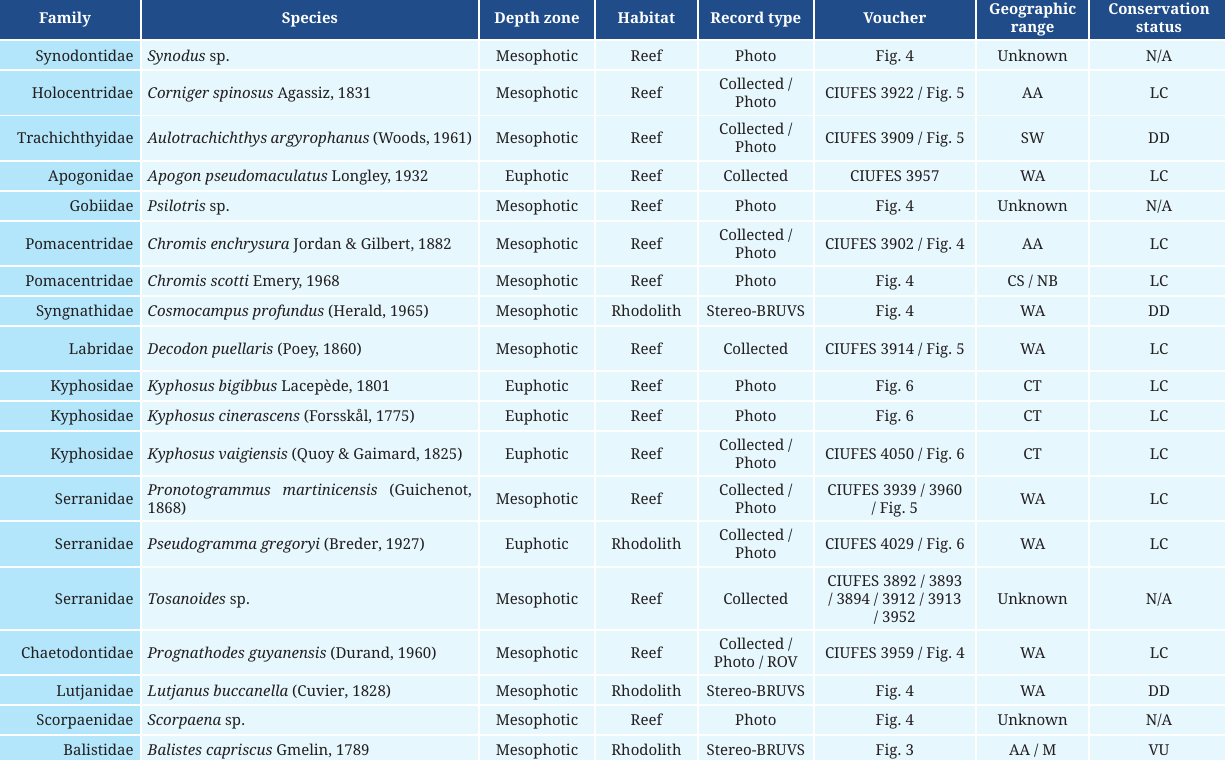
TABLE 1 | New records of fishes from Fernando de Noronha Archipelago, north-eastern Brazil. Families are presented in phylogenetic order according to Nelson et al . (2016). Information about depth zone, habitat, record type and voucher of the new records, as well as distribution and conservation status of the species are presented. Depth zone of the record: euphotic (≤ 30 m deep) and mesophotic (31 to 150 m deep). Geographic range: amphi-Atlantic (AA), Caribbean Sea (CS), Circumtropical (CT), Mediterranean (M), Northern Brazil (NB), South-western Atlantic (SW) and Western Atlantic (WA). International Union for Conservation of Nature and Natural Resources (IUCN) conservation status: data deficient (DD), least concern (LC), and vulnerable (VU); N/A: not